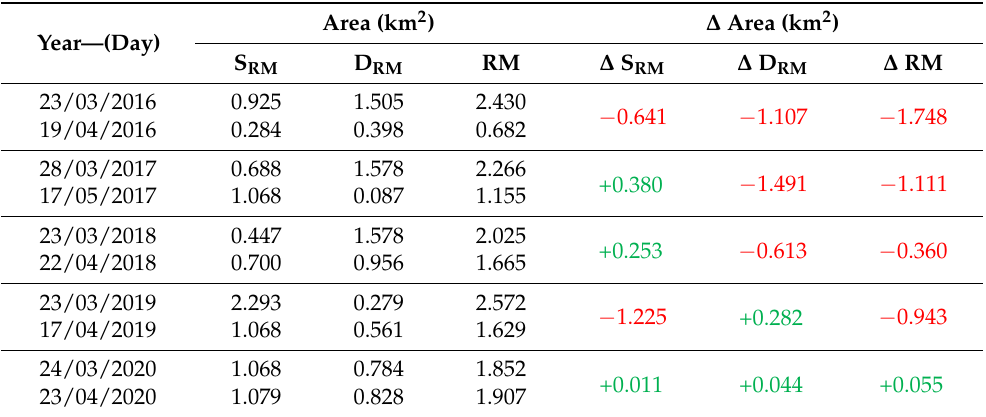
Table 3. Comparison of area (km 2 ) occupied by macrophyte classes (S RM , D RM , and RM) for the two spring images (early spring vs. late spring) of each year (2016–2020). In green are positive values (increase of area) and in red are negative values (decrease in area).